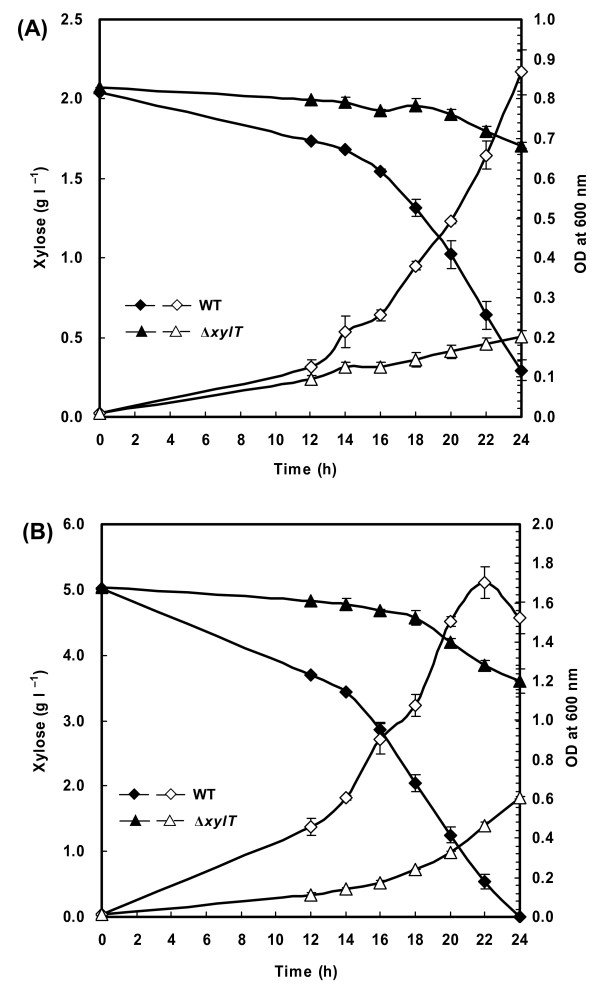
Effect of xylT disruption on cell growth and xylose utilization of C. acetobutylicum. Cells were grown in the medium containing 2 g l-1 (A) or 5 g l-1 (B) of D-xylose as the sole carbon source. Open symbols, optical density at 600 nm; filled symbols, xylose concentration in the medium. Data shown are means ± standard deviations calculated from triplicate individual experiments.